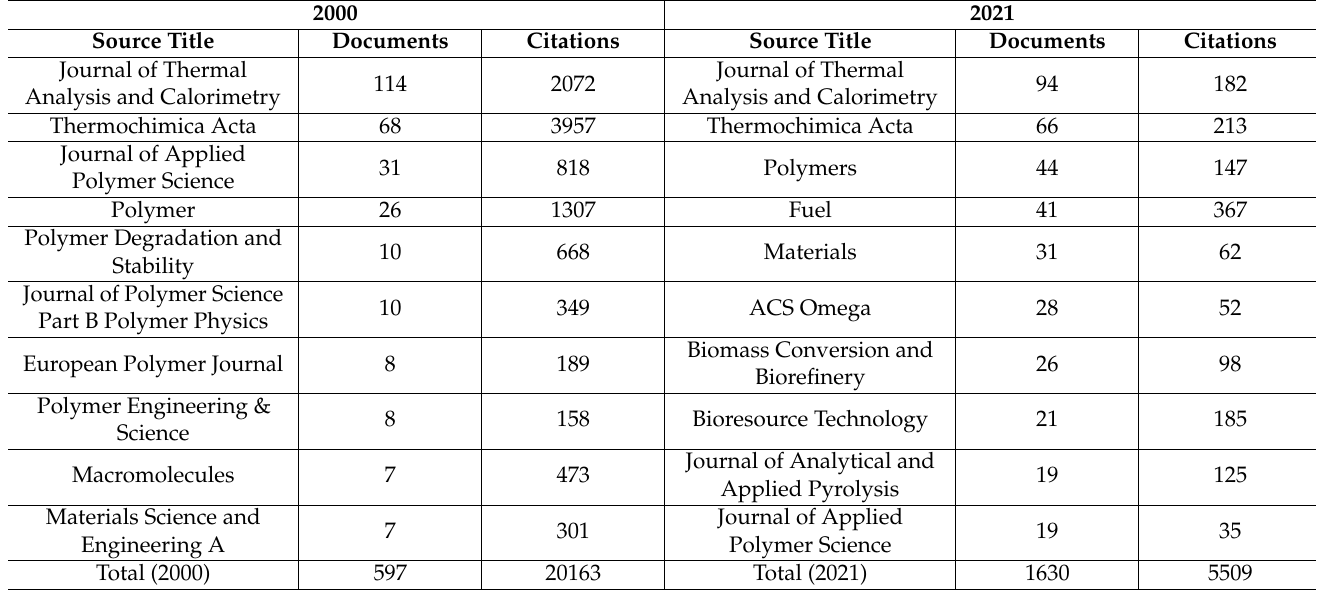
Table 1. Number of documents and citations by journal title, for thermokinetic papers published at 2000 and 2021 (only top ten journals by publications number are